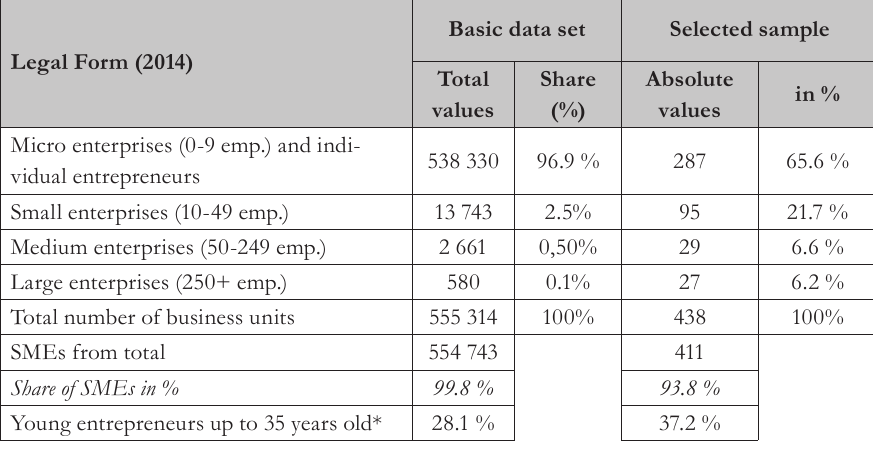
Tab. 1 - Number of entrepreneurs in Slovakia in 2014 – comparison of the basic data set and the selected